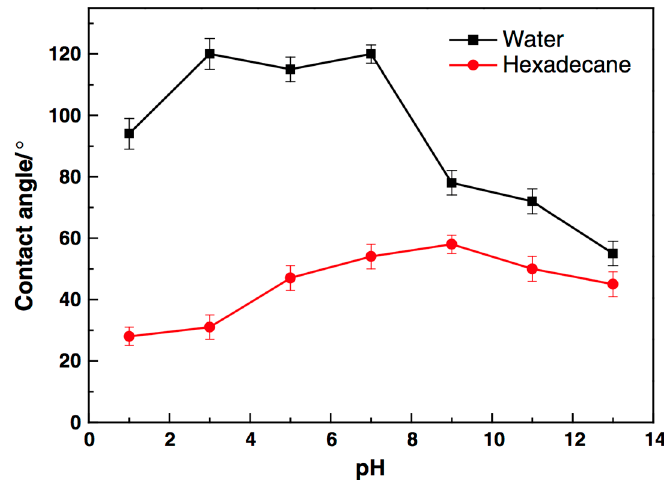
Figure 8. Impact of pH in the performance of fluoropolymer. Reproduced with permission from [87].